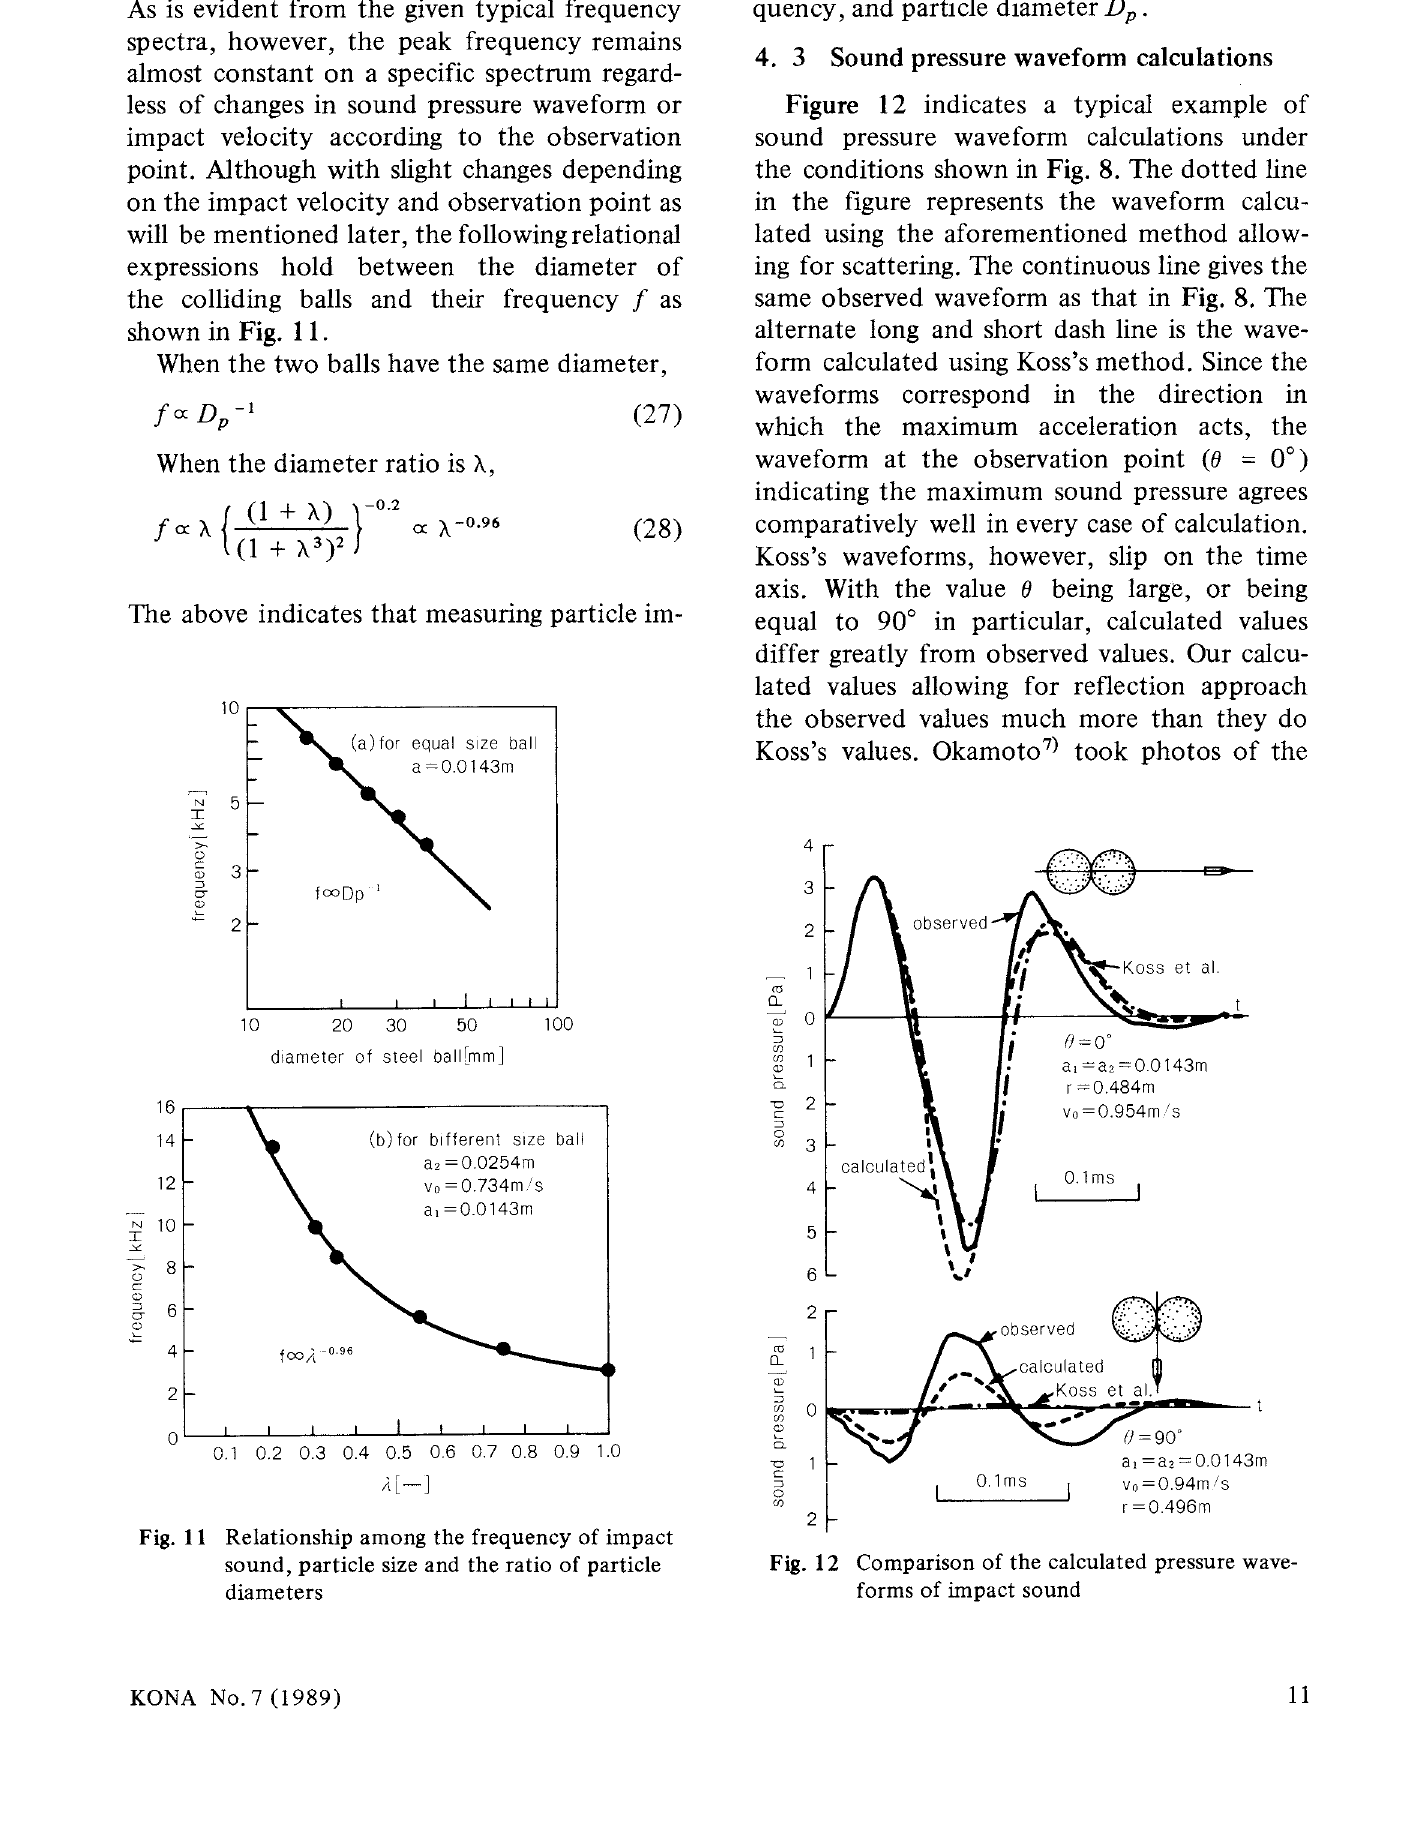
Fig. 12 Comparison of the calculated pressure wave forms of impact